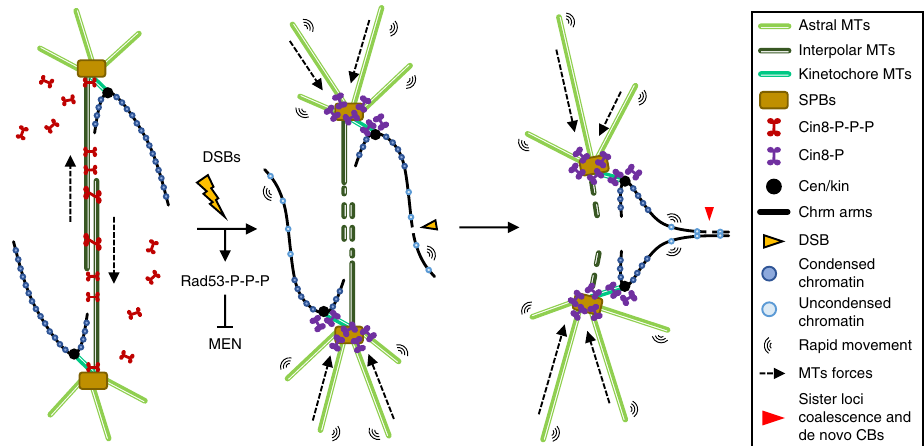
Fig. 8 Model for the effect of DSBs on segregated sister chromatids. Segregated sister chromatids are maintained away from each other in telophase. Two complementary mechanisms aid to this aim. Firstly, an elongated spindle is maintained by the action of kinesin-5 Cin8 on interpolar microtubules (iMTs). Secondly, segregated sister chromatids are in a hypercondensed state 54 . DSBs locally mobilise the affected chromatin through decondensation, so the histone-poor signal in de novo chromatin bridges, and globally accelerate loci movement. In addition, Cin8 is displaced out of iMTs by partial dephosphorylation, abrogating the spindle forces that keep SPBs far from each other. It is likely that enforced astral MTs also participate in bringing closer the SPBs. All these circumstances make possible for sister loci at chromosome arms to coalesce and repair DSBs through HR with the sister chromatid, even when cells are in